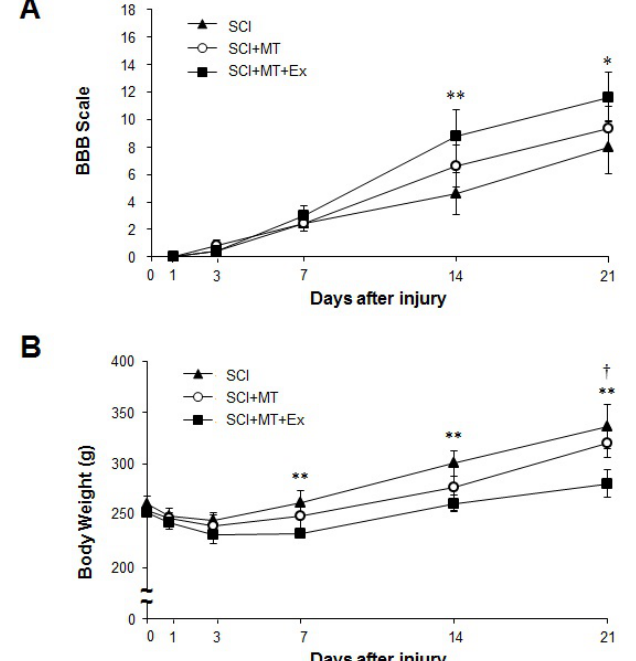
Figure 1. Effect of therapeutic interventions of melatonin and melatonin combined exercise on motor function recovery after spinal cord injury. ( A ) Recovery of motor function and change of body weight during 21 days after SCI. Values of the BBB rating scale are presented. Rats were treated with saline (SCI) or melatonin (SCI+MT, SCI+MT+Ex) from day 1 after injury. Three days after injury, treadmill exercise was combined with melatonin (SCI+MT+Ex). SCI+MT+Ex group demonstrated significant improvement at day 14 and 21 after injury, compared with SCI (* p < 0.05, ** p < 0.01). ( B ) SCI+MT+Ex induced less gain of body weight compared with SCI. There were significant differences between SCI+MT+Ex and SCI group at day 7, 14 and 21, respectively (** p < 0.01). Moreover, the body weight of SCI+MT+Ex was lower than SCI+MT at day 21 († p < 0.05). Statistical significance test was done by one-way ANOVA. Data are shown as the mean ±